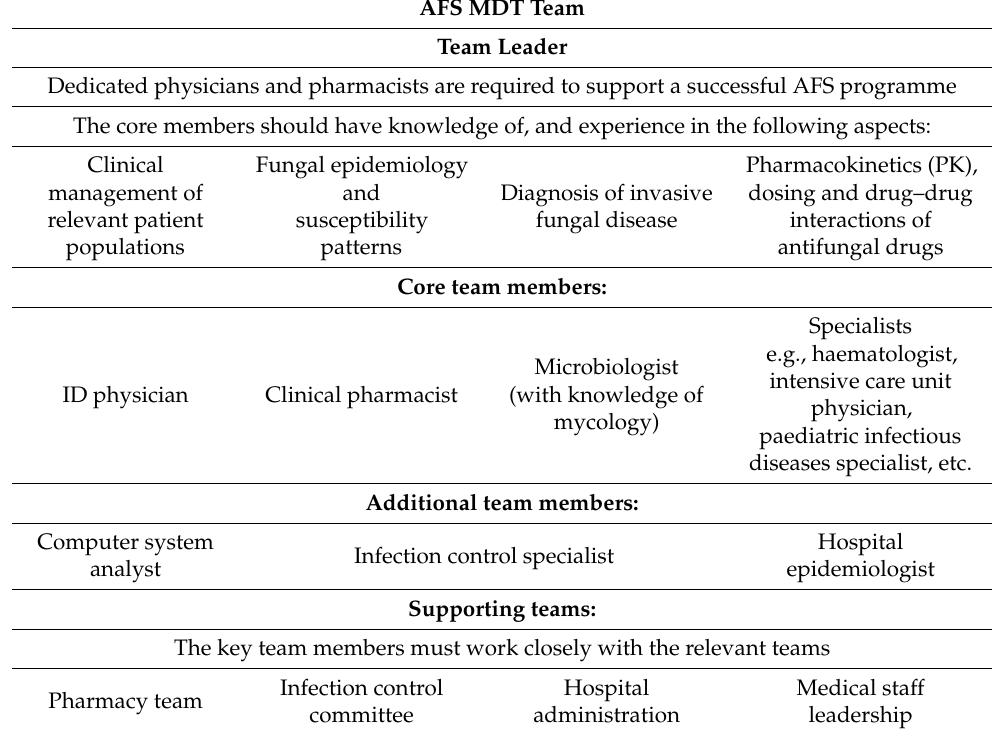
Table 1. Proposed structure of an MDT team for successful AFS